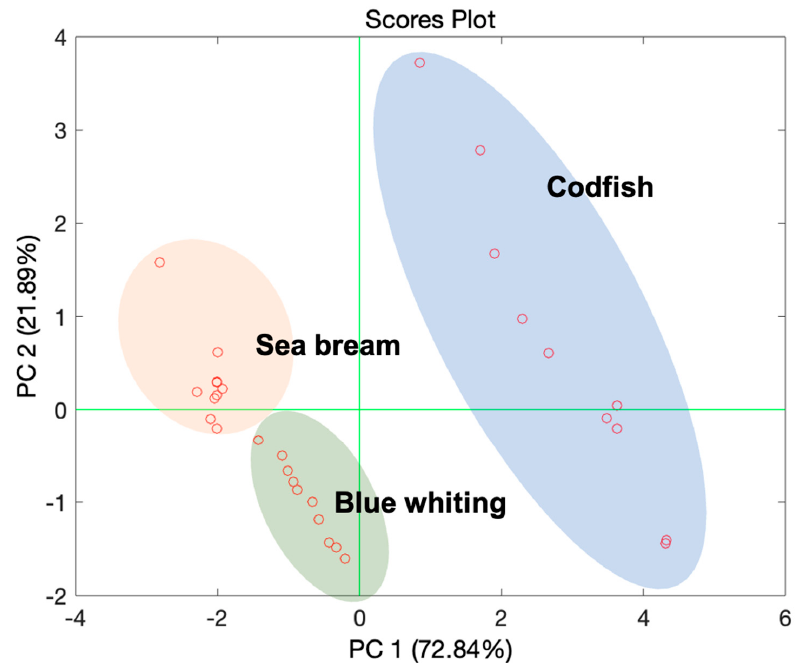
Figure 8. Scores plot of the first two principal components (PCs) of the PCA model elaborated on the dataset registered by the BIONOTE-V in the analysis of the samples of fishes pertaining the three species considered for the experiment: codfish, sea bream, blue whiting. For each of them a specific cluster has been defined on the PCs plane.